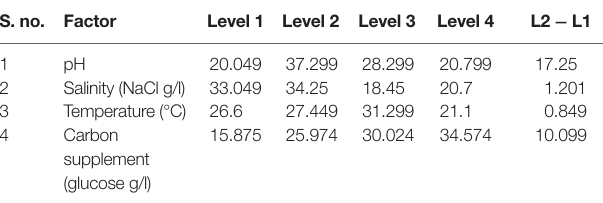
TaBle 3 | Main effects of selected factors on total lipids production.